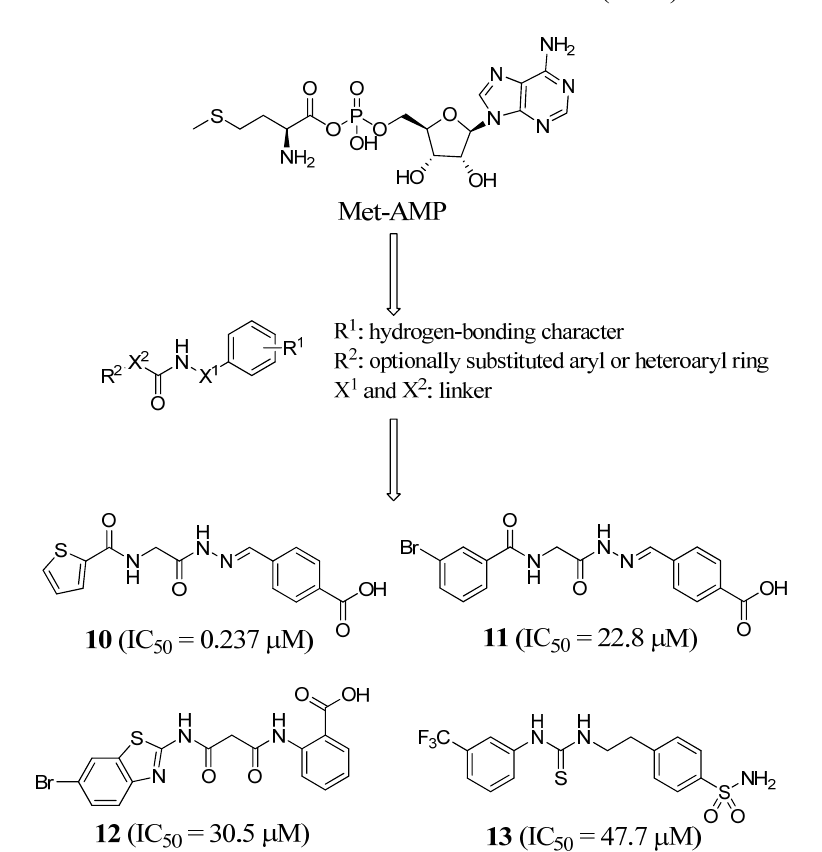
Figure 5. Inhibitor identification scheme of Kim et al. (2006) for MetRS